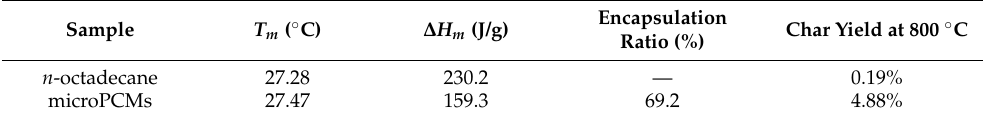
Figure 6. DSC curves of pure n -octadecane and the microPCMs. Table 3. Thermal properties of the microPCMs with the MF resin